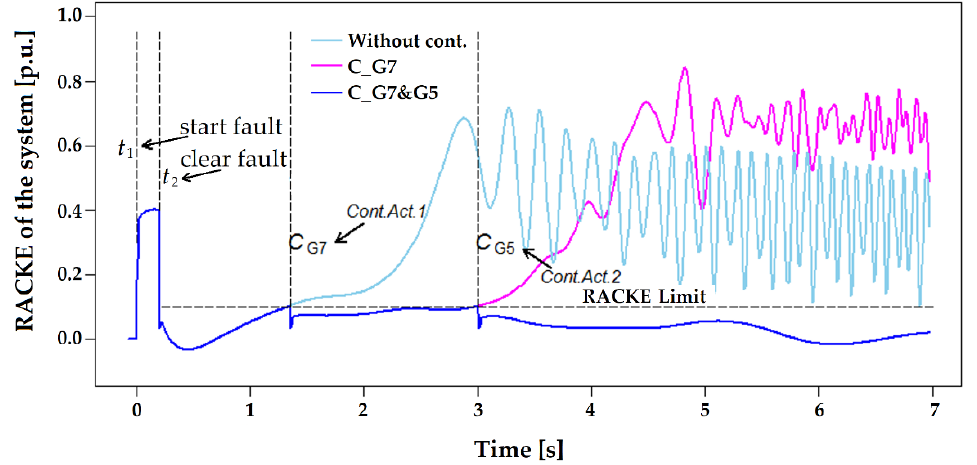
Figure 13. RACKE_SIS vs. time, with and without control.